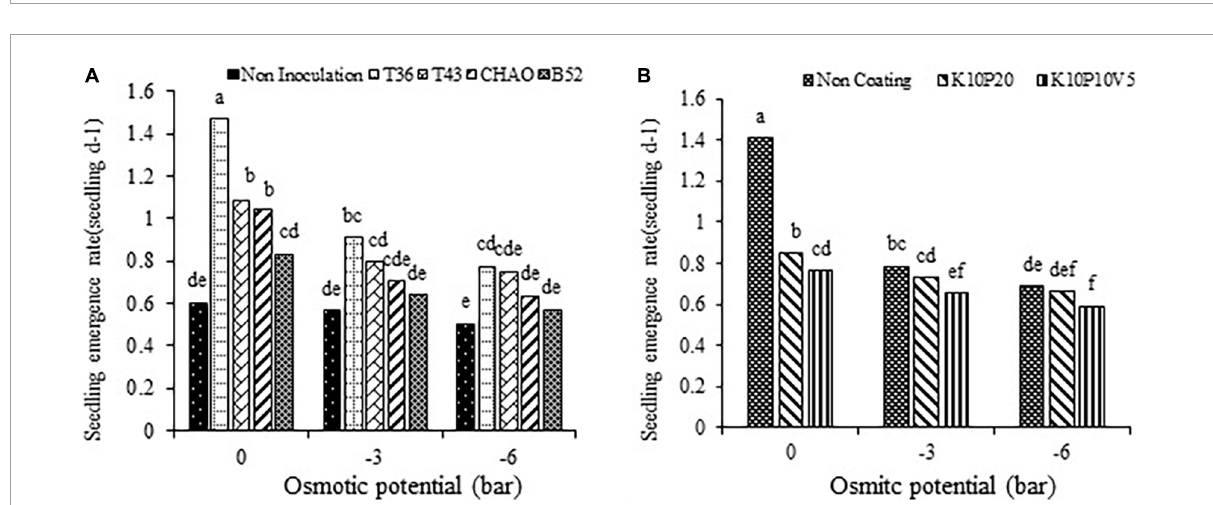
FIGURE6 Mean comparison of the effect of (A) seed inoculation and (B) seed coating on seedling emergence rate (seedling d - 1 ) of anise at different levels of drought stress. Means with the same letter are not significantly different according to the HSD test at P = 0.05. CHA0, B52 of Pseudomonas fluorescens , T36 and T43 of Trichoderma harzianum isolates. K, kaolin; V, vermiculite; P,